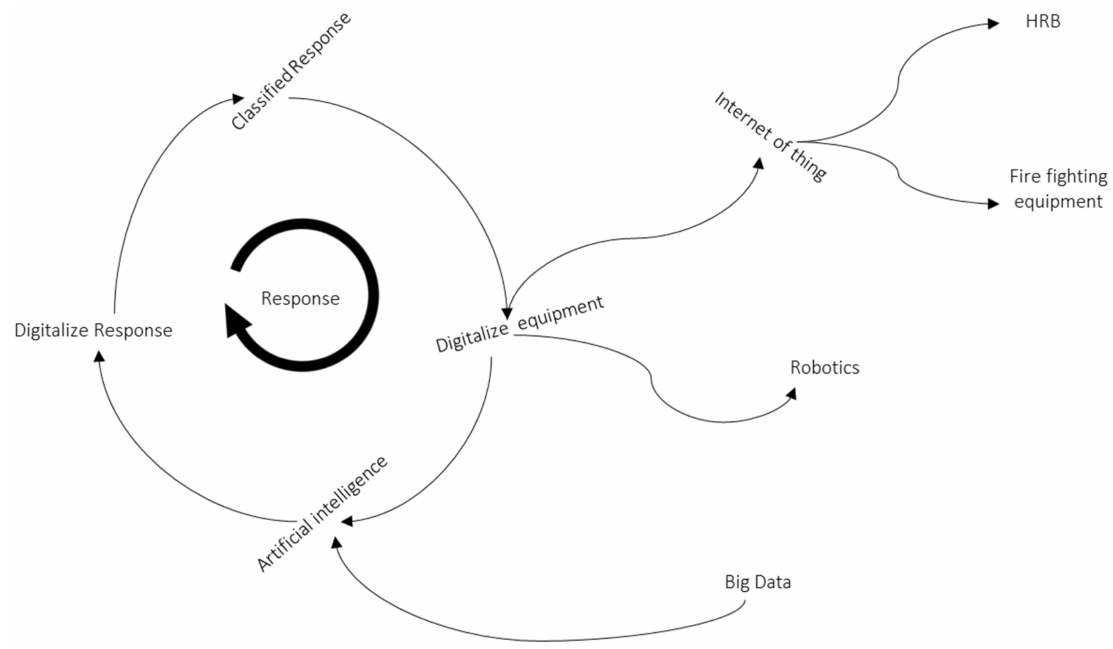
Figure 3. Response